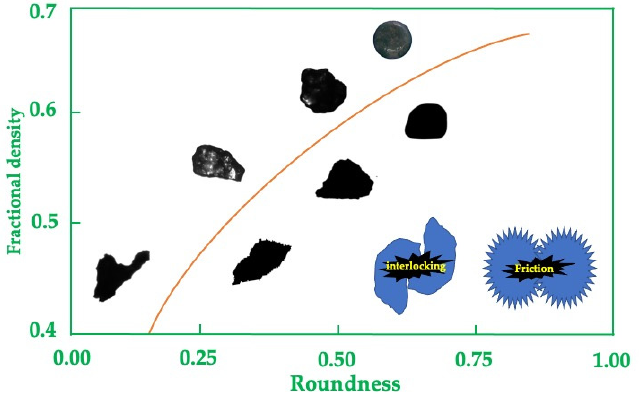
Figure 24. Bulk density as a function of particle roundness, (modified from [265].